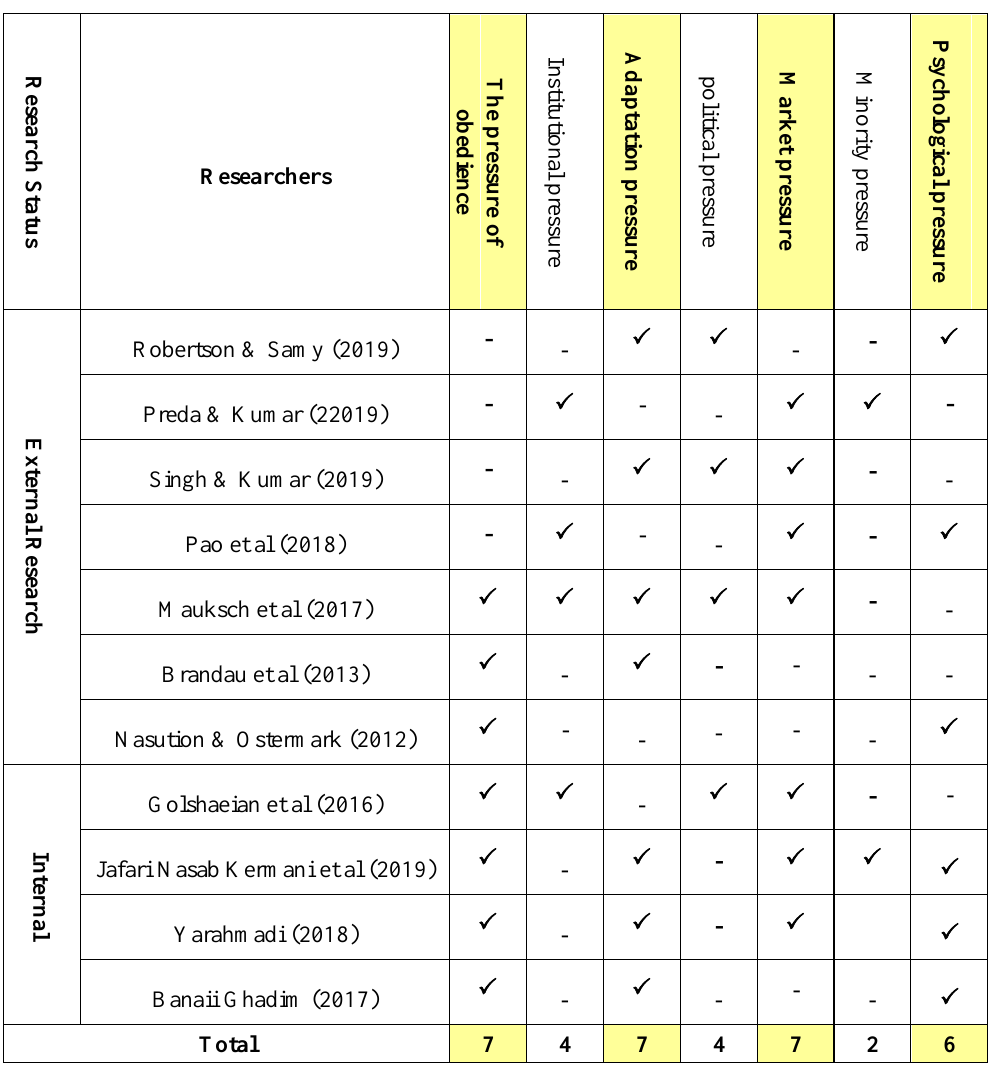
Table 2. The process of determining the main research